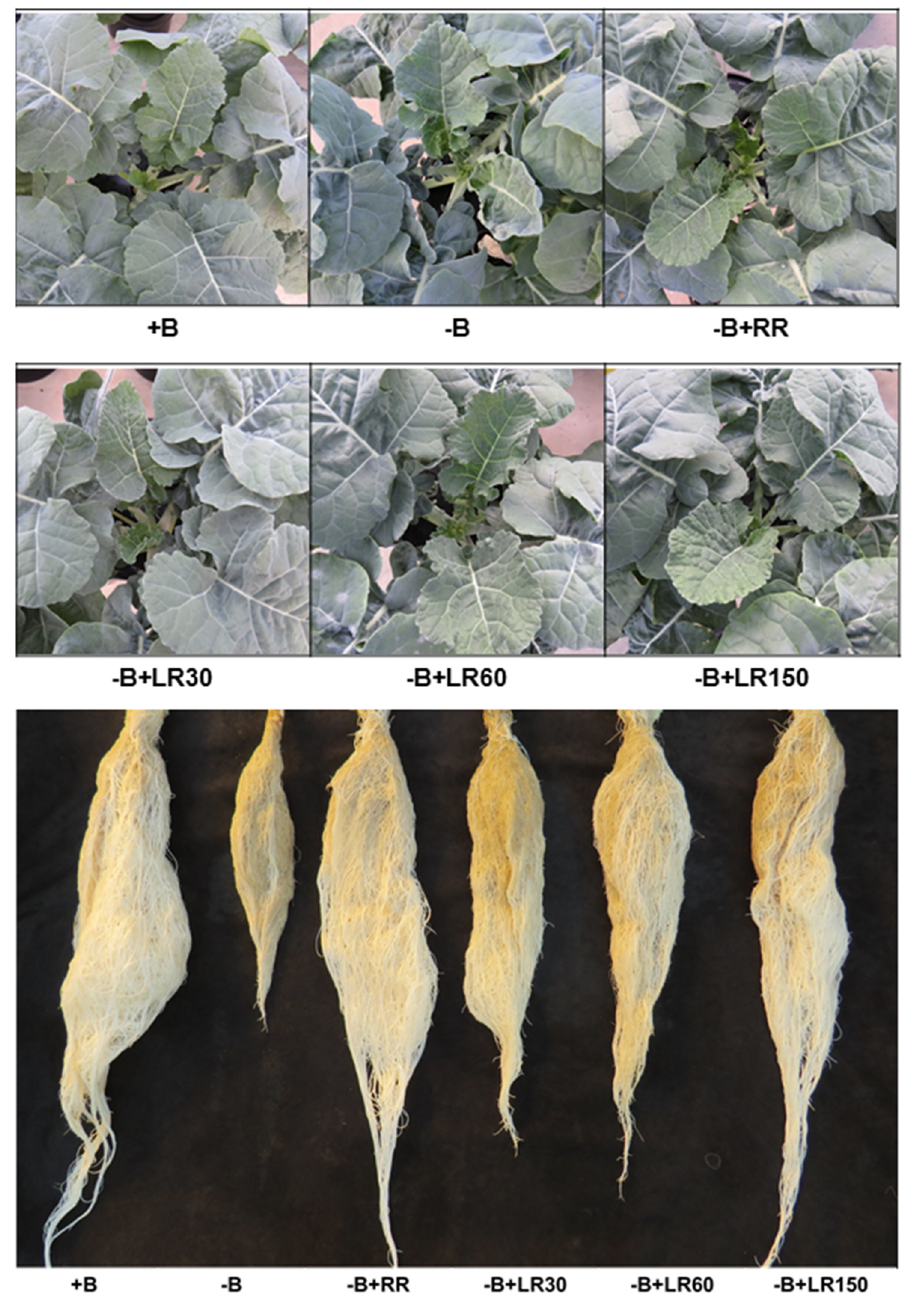
Figure 1. Response of B. napus to different B treatments after 42 days of transplantation in the nutrient solution. +B, 25 µM B in NS; − B, 0.25 µM B in NS; − B+RR, 0.25 µM B in NS for the first two weeks and then 25 µM B for the latter two weeks; − B+LR 30 , 0.25 µM B in NS and foliar-applied 30 mM B at two weeks; − B+LR 60 , 0.25 µM B in NS and foliar-applied 60 mM B at two weeks; − B+LR 150 , 0.25 µM B in NS and foliar-applied 150 mM B at two weeks.